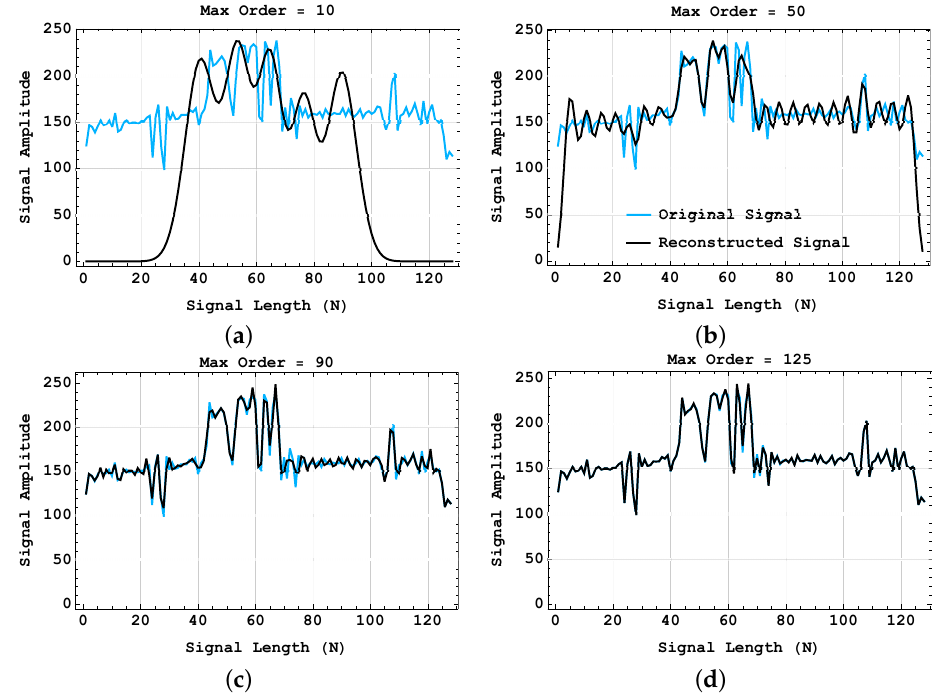
Figure 11. Signal reconstruction of the blue signal in Figure 9b with different maximum orders: ( a ) 10, ( b ) 50, ( c ) 90, and ( d ) 125. p =